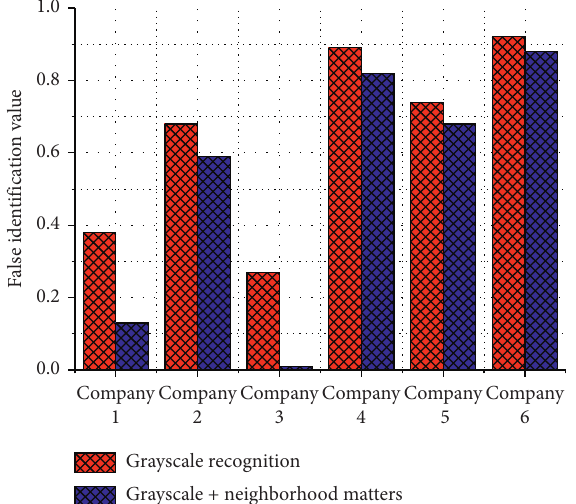
Figure 6: Comparison of false recognition effect under two kinds of